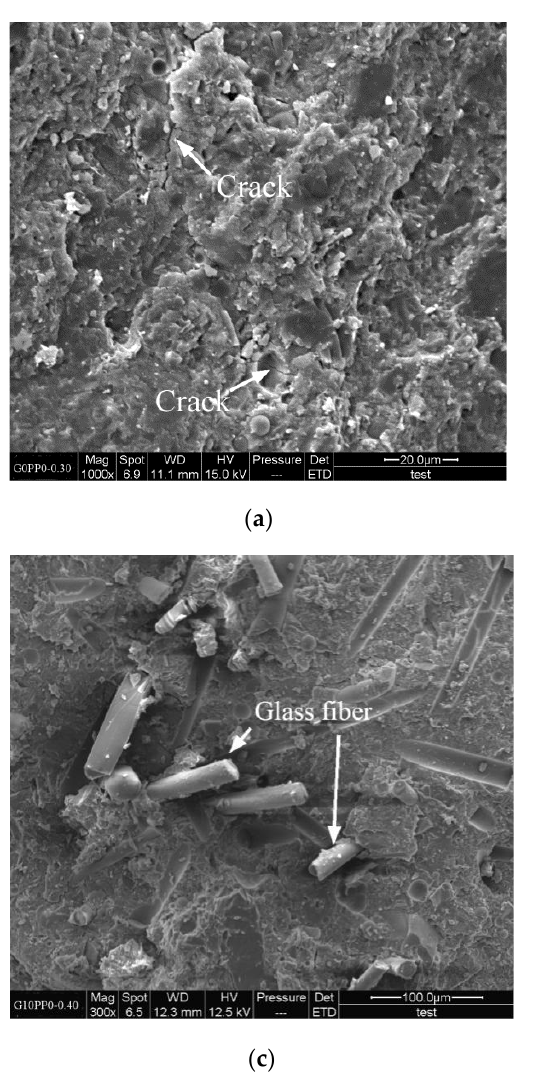
( b ) Figure 5. The average abrasion resistance level of each group of samples: ( a ) Average abrasion re- sistance level of each group of samples; ( b ) Average abrasion resistance level of each group of sam- ples after removing the lowest water/binder ratio. 3.4. Microstructure Figure 6 shows the scanning electron microscope (SEM) images of some representa- tive mortar samples. Figure 6a shows the microstructure of G0PP0-0.30. It can be seen that when the fiber incorporation amount is 0, cracks occur on the gel surface due to hardening and shrinkage. As shown in Figure 6b, although no cracks were generated after 2% GF was added, the low water/binder ratio (w/b = 0.27) and fiber incorporation resulted in the poor working performance of fresh mortar and difficulty in molding, resulting in a large